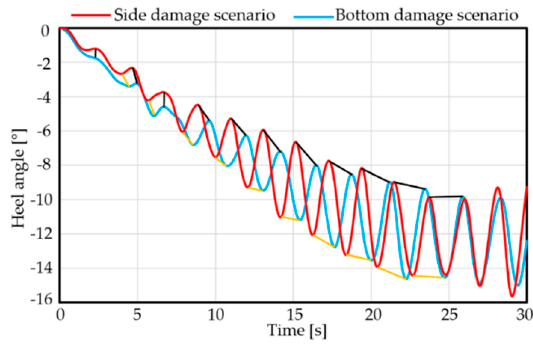
Figure 14. Comparison of heel angles in different damage scenarios.